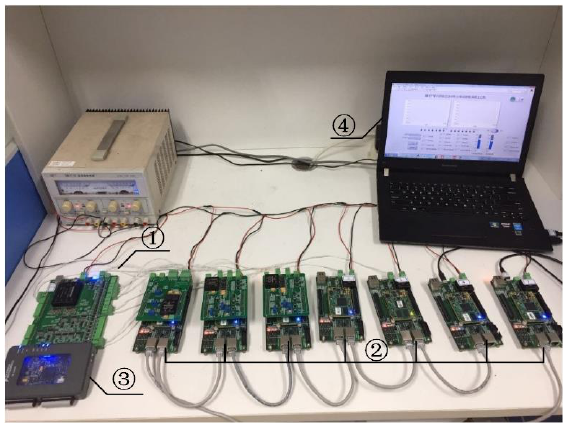
Figure 12. Hardware-in-the-loop simulation platform. ① Interface simulator ② Distributed con- troller ③ myRIO (Engine CLM) ④ Monitor.